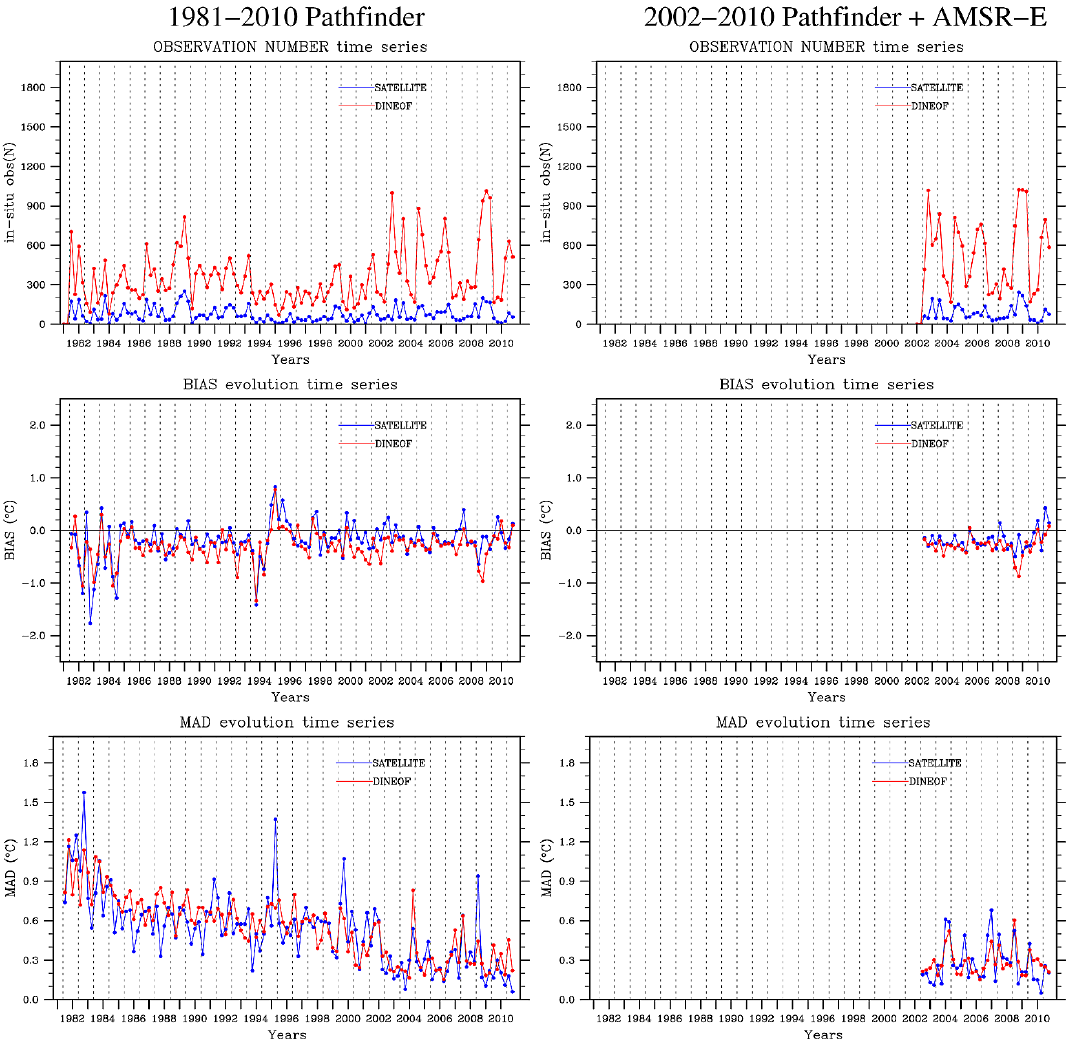
Fig. 3. Time evolution of the monthly number of observations (top panels), the bias (middle panels) and MAD (bottom panels) error estimates. Panels are organised as in Fig. 2. Blue lines indicate estimates obtained from data pairs of originally non-missing satellite data and their ICOADS counterparts while the red ones indicate the same but for the reconstructed datasets. The same time axis is used for the 1981–2010 and the 2002–2010 reconstructions in order to allow an easier